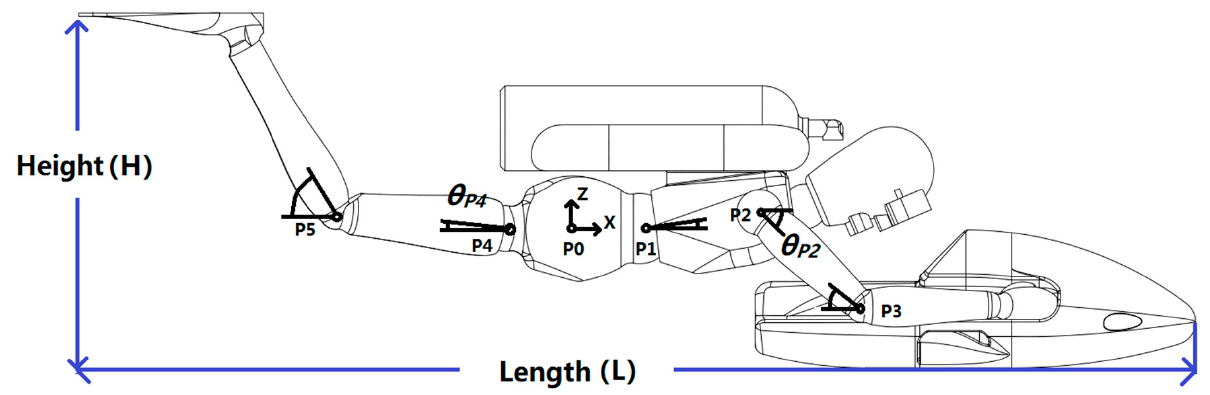
Figure 6. Notations of model’s dimension and posture.